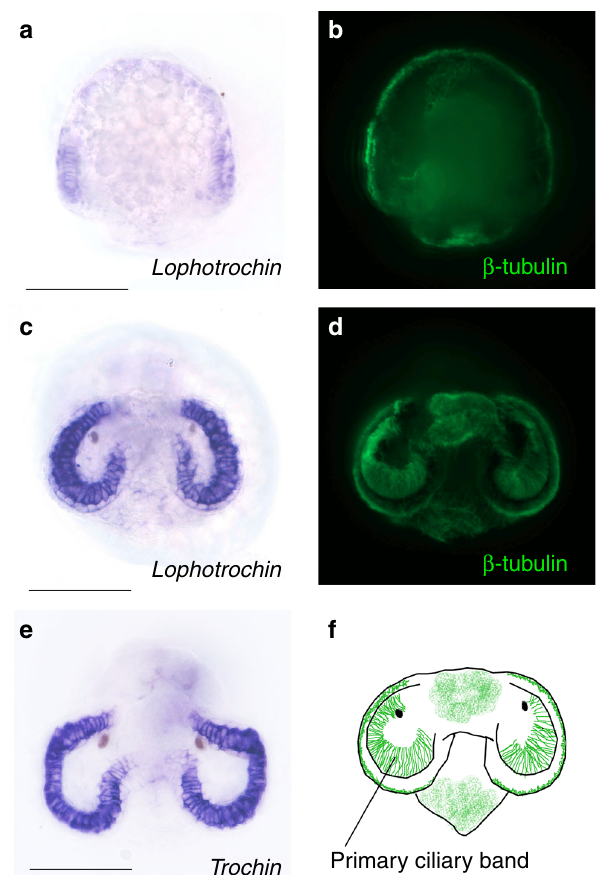
Fig. 2 Lophotrochin and trochin expression in the mollusc Tritia obsoleta . a Anterior view of an early (around 3-day old) embryo at the onset of primary ciliary band formation, stained for lophotrochin (purple), and b for cilia (green). c In a later stage larva (around 7 day old), lophotrochin expression is speci fi c to the primiary ciliary band (prototroch). d Same larva as on ( c ) showing cilia. e Seven-day-old larva stained for trochin (purple); the expression is speci fi c to the cells of the primary ciliary band. Lophotrochin and Trochin are expressed in the ciliated cells of the midgut in later larvae (not shown). f Cartoon of the anterior view of larva; the primary ciliary band (green) spans the velar lobes (based on ( d )). Other shorter cilia are found on the middle of the head, and the foot. Scale bars: 100 μ m. For each in situ hybridization, at least 20 animals were stained and all had the pattern